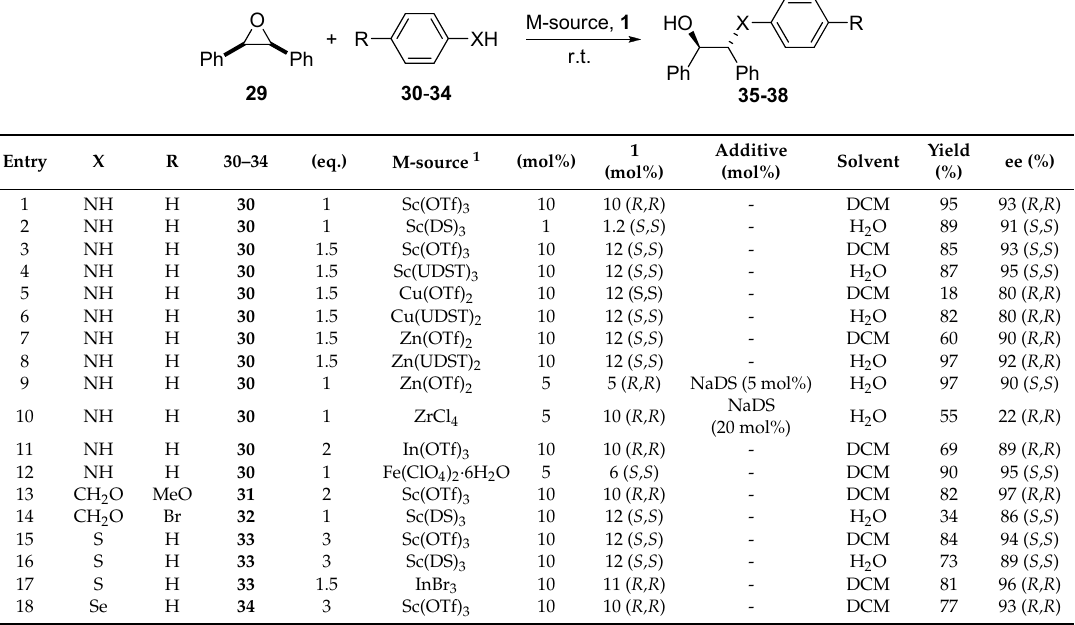
Table 7. Opening of epoxide ring by amine, alcohol, thiol, and selenol.